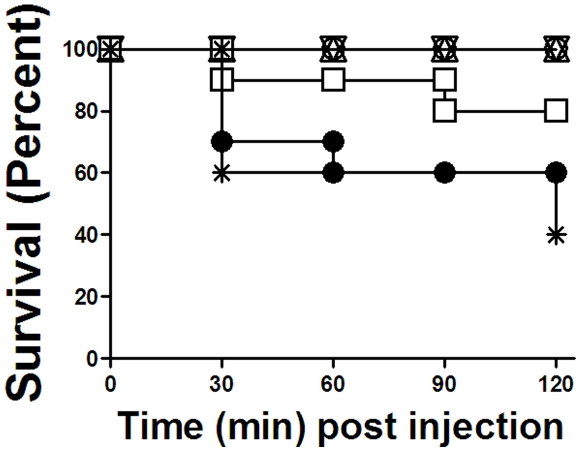
IVIg prevents 34-1-2s-induced TRALI mortality in SCID mice.Kaplan-Meier survival plots of SCID mice (N = 10 for each dose group). SCID mice were not treated (○) or administered 34-1-2s (•, 2 mg/kg). Some mice were treated prophylactically 18 hours before 34-1-2s infusion with either a control infusion of 2 g/kg HSA () or 2 g/kg of IVIg (▵) or 1 g/kg of IVIg (▿). The other mice were treated within 3 minutes after TRALI induction with 1 g/kg of IVIg (□). The data is expressed as percentage of mice surviving at the indicated times after TRALI induction. No BALB/c mice treated with 9 mg/kg 34-1-2s died during the experimental protocol. Significance was determined by a Log ranked Mantel-Cox test between 34-1-2s infused mice (•) and prophylactically IVIg treated (▵, 2 g/kg) mice); p = 0.0289 (the survival curves are significantly different.